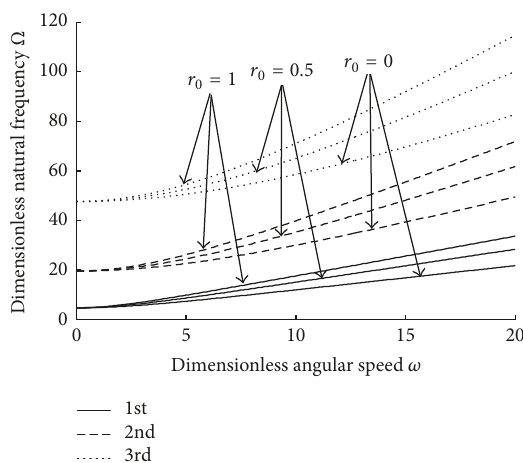
Figure 8: Variation of the first three dimensionless natural fre- quencies of rotating solid tapered beams with dimensionless angular speed of the hub for various 𝜆 = 0.25 , 0.5 , 0.75 at 𝑟 = 1/30 , 𝑟 0 = 0